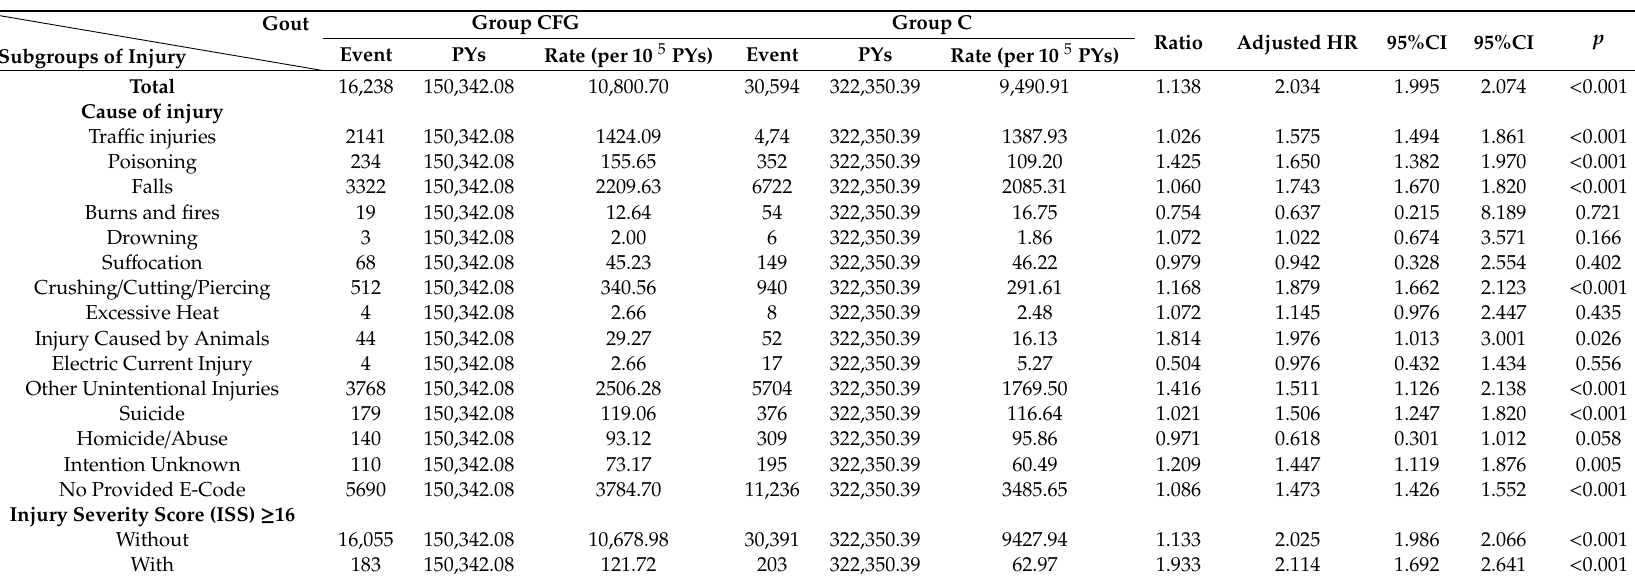
Table 5. Relationship between the Occurrence of Subgroup Injuries in Patients with Gout (Group CFG) and Without Gout (Group C). Subgroups of